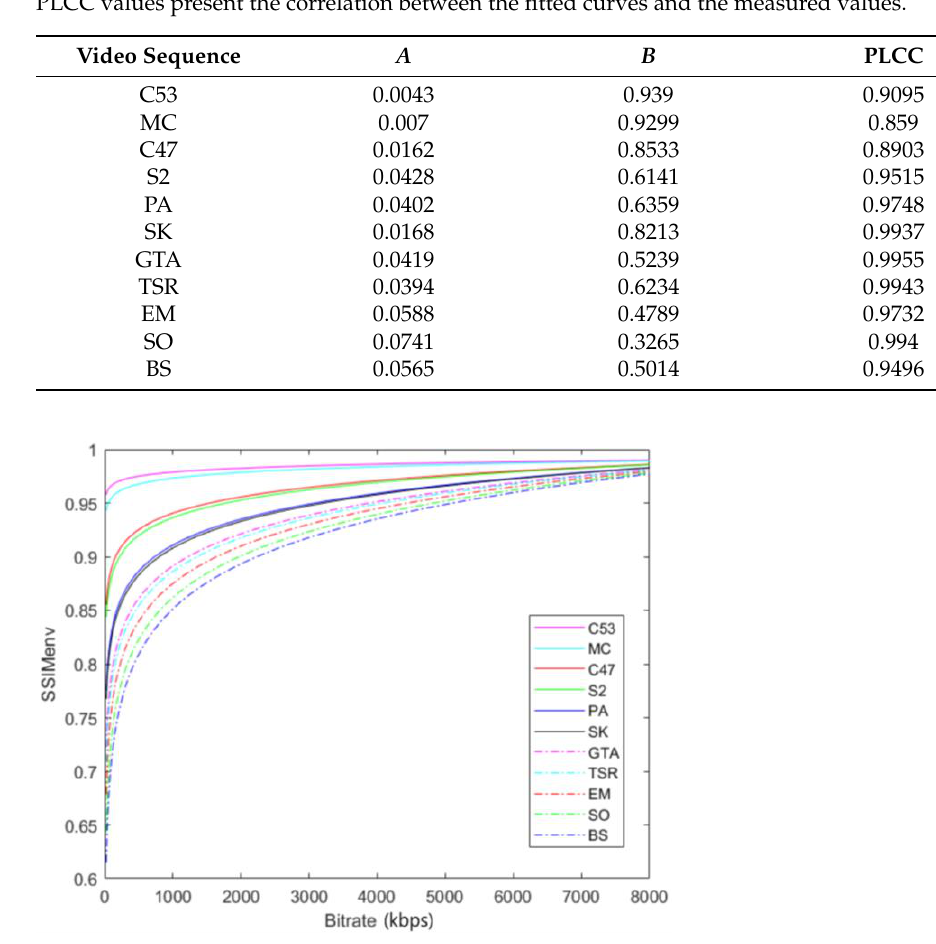
Figure 4. Fitted curves of data points presenting the envelope of SSIM-achieved bitrate curves for video sequences: ( a ) Skateboarding (SK); ( b ) El Fuente Mask (EM). Table 3. Values of A and B coefficients for every video sequence used in the modeling process. PLCC values present the correlation between the fitted curves and the measured values.